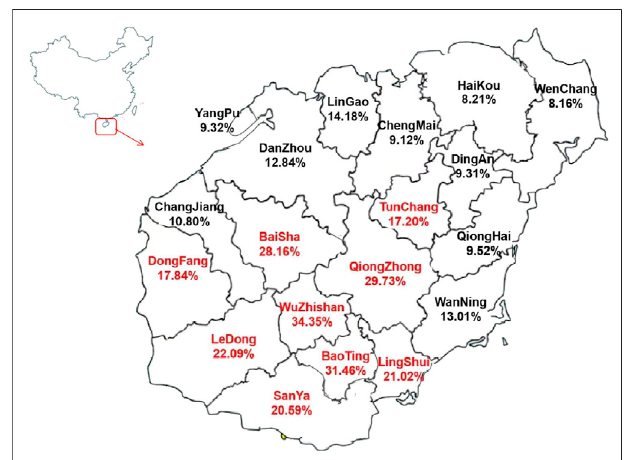
FIGURE 1 | Prevalence of thalassemia in different regions of the Hainan